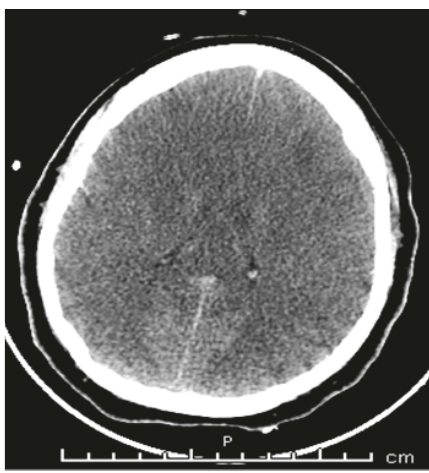
Figure 2: Noncontrast head computed tomography (CT) showing diffuse sulcal effacement, obliterated basal cisterns, and hyperden- sity in the interhemispheric